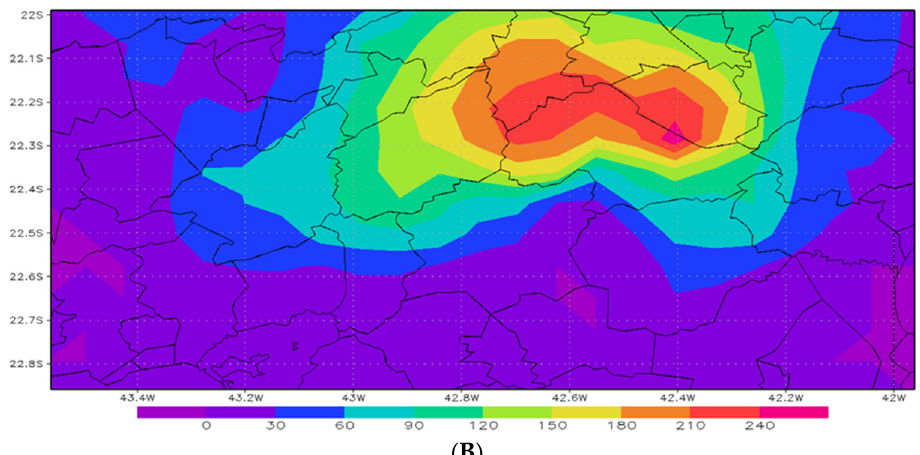
Figure 8. Estimation of daily precipitation in mm, with data from SOAS, at the coordinates of the mountainous region of Rio de Janeiro. ( A ) 11 January 2011, ( B ) 12 January 2011.